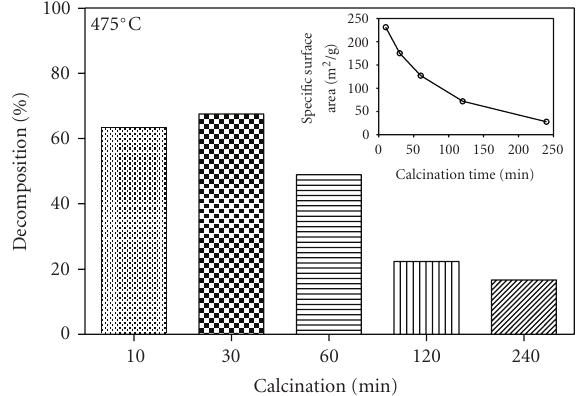
Figure 5: Photocatalytic 4-CP decomposition results of the pow- ders calcined at 475 ◦ C for various times in O 2 atmosphere and variation of specific surface area shown in inset.